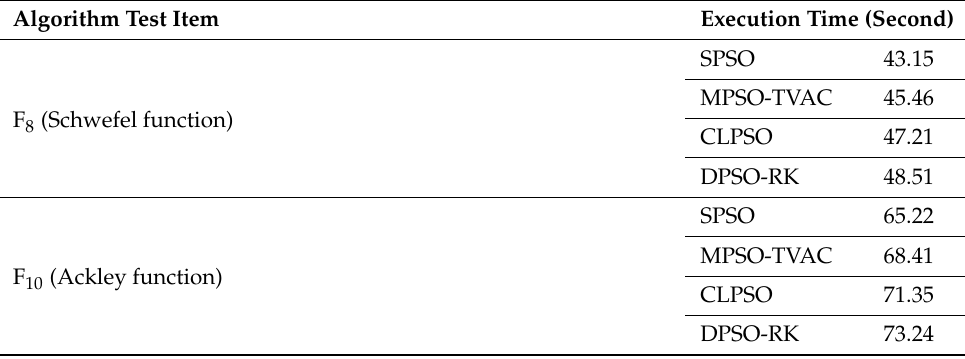
Figure 3. Comparison of dynamic performance of four algorithms in the case of 300 dimensions. ( a ) F 8 function, ( b ) F 10 function, ( c ) F 11 function, ( d ) F 12 function, and ( e ) F 13 function. ( f ) algorithm icon illustration. Table 2. Algorithm execution time of 3 DPSO in F 8 ~F 13 . Table 3. The algorithm execution time of different 4 PSOs in F 8 ~F 13